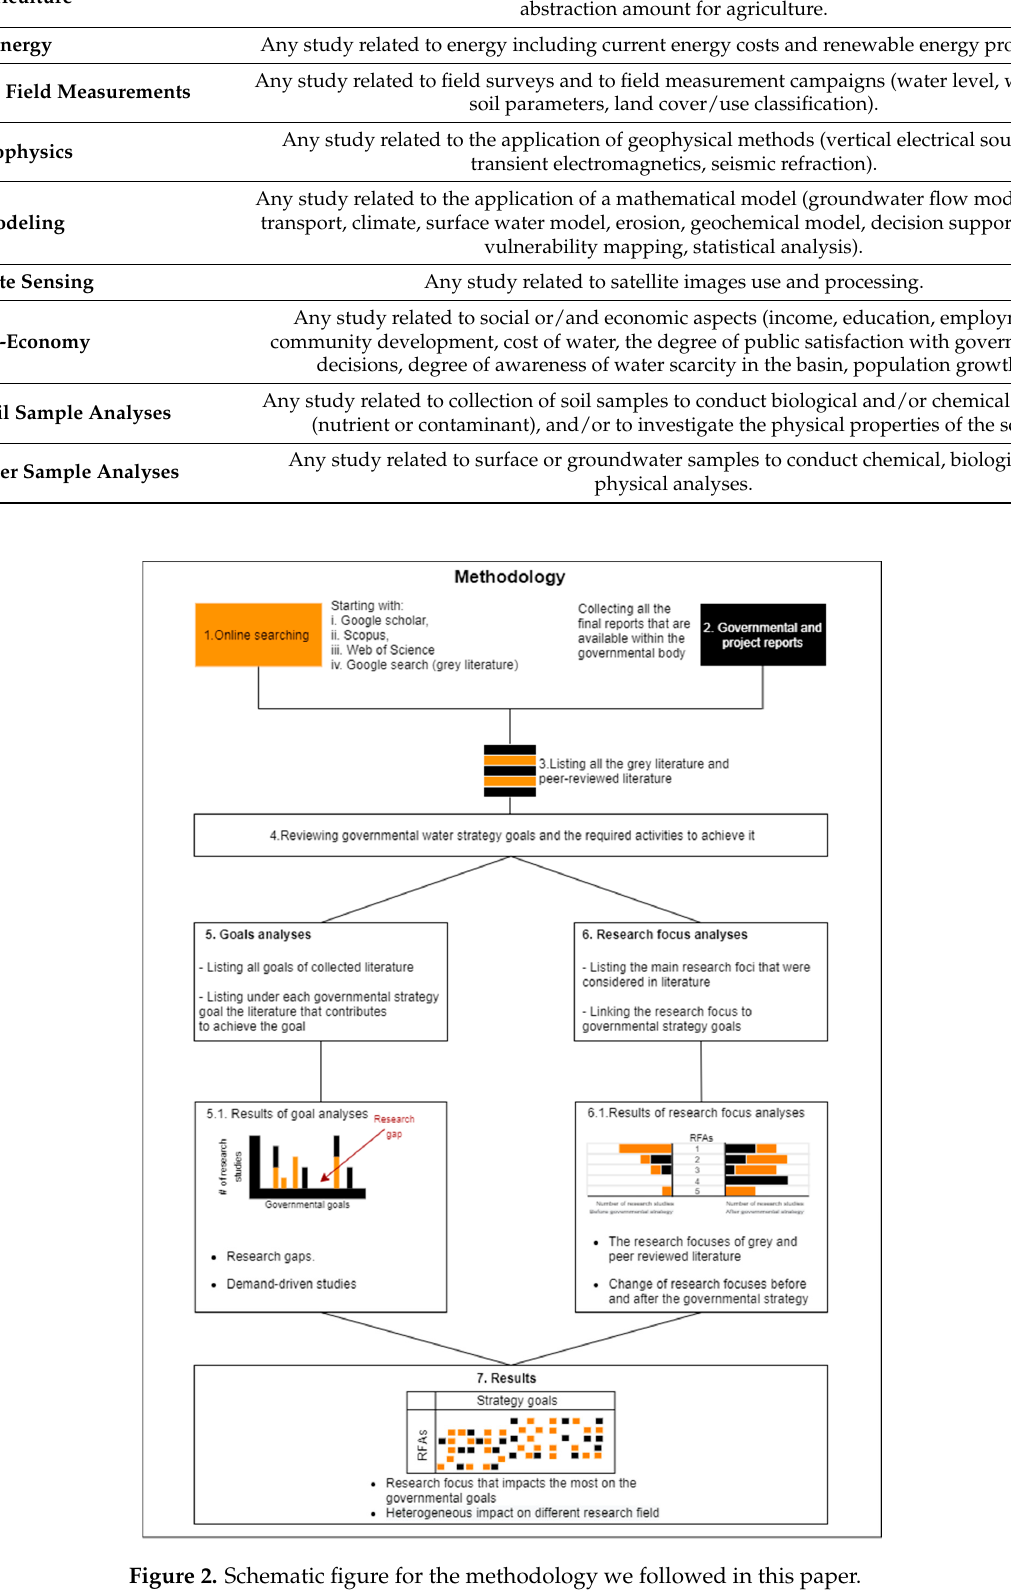
Table 3. Description of the categorization of the research focus areas (RFAs) in the collected studies. Research Focus Area (RFA) Included: